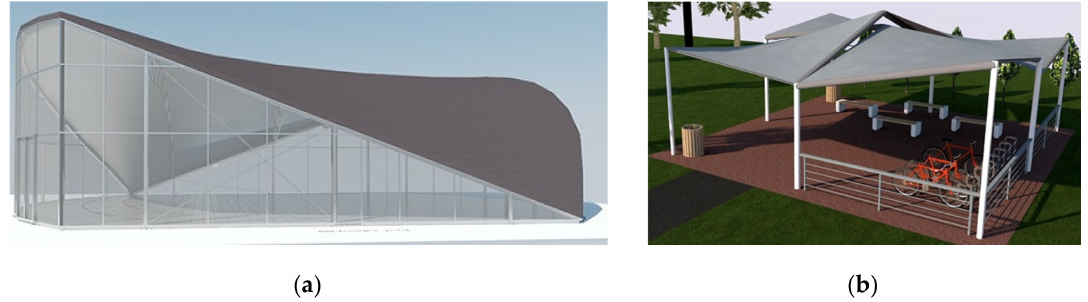
Figure 9. Architectural phase of: ( a ) a complete free-form building, ( b ) a shell roof structure composed of four hyperbolic